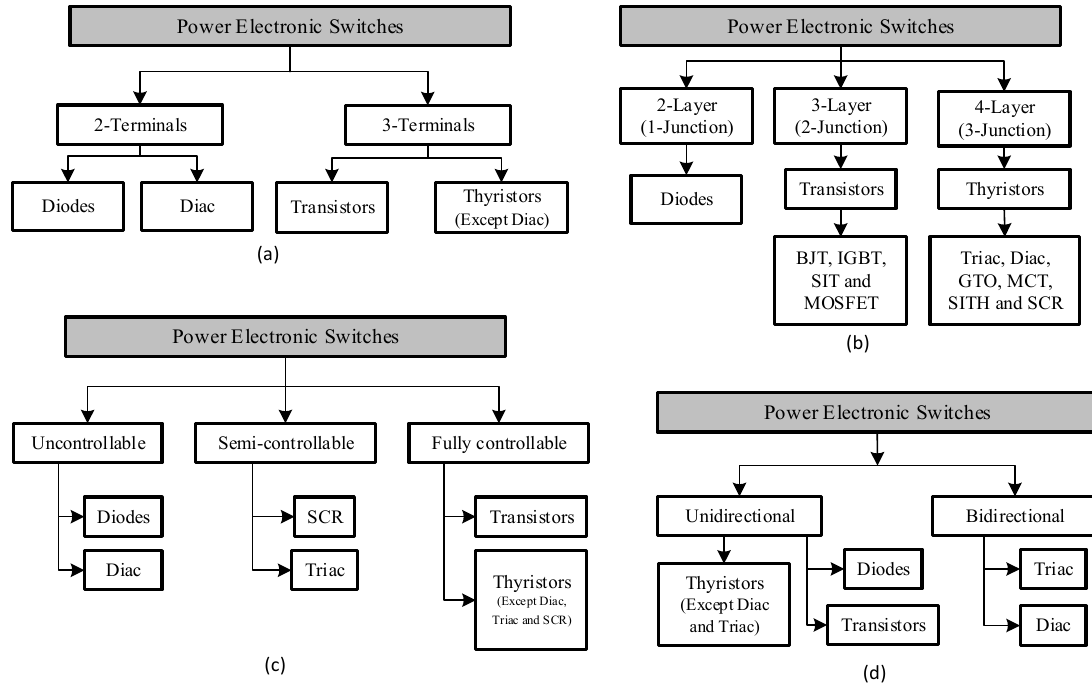
Figure 2. Classification of modern power electronic switches based on ( a ) number of terminals, ( b ) number of layers or junctions, ( c ) controllability and ( d ) bidirectional capability.